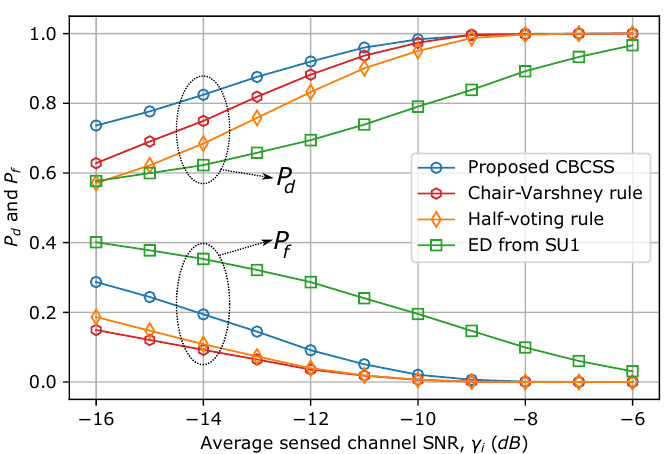
Figure 7. Probabilities of detection and false alarm according to average SNRs for different sensing schemes. ED: energy detection.